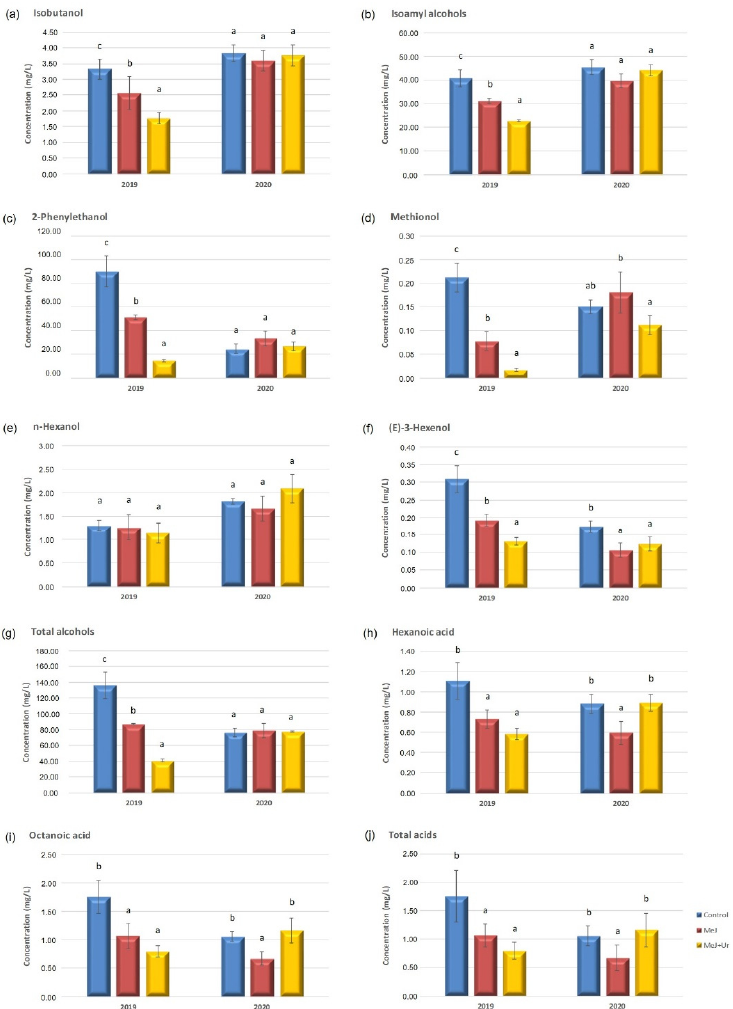
Figure 2. Alcohols and acids concentration (mg/L) in Tempranillo wines from control, MeJ and MeJ+Ur treatments in 2019 and 2020 seasons. All parameters are given with their standard deviation ( n = 3). For each season and compound, different letters indicate significant differences between samples ( p ≤ 0.05). 3.4. Influence of the Foliar MeJ and MeJ+Ur Treatments on Wine Nitrogen Compounds